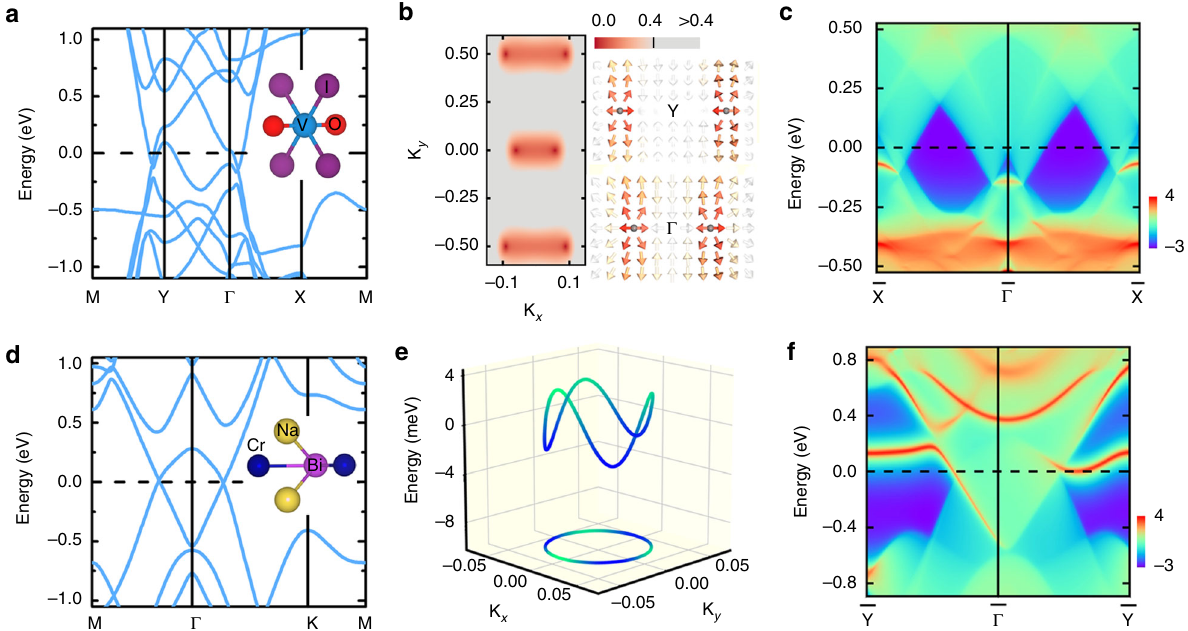
Fig. 5 Realization of mixed topological semimetals in two-dimensional ferromagnets. Including SOC, the electronic band structures of the stable single- layer compounds a VOI 2 and d Na 2 CrBi display band crossings with non-trivial topological properties in the mixed phase space of crystal momentum k = ( k x , k y ) and magnetization direction θ . Side views of the corresponding unit cells are shown as insets. b The signatures of the mixed Weyl points for in-plane magnetized VOI 2 manifest in the momentum-resolved direct band gap (color scale in eV) and in the distribution of the Berry curvature fi eld shown as arrows throughout the complex phase space, con fi rming the presence of four nodal points with the same topological charge. Ranging from white (small) to dark red (large), the arrow ’ s color illustrates the magnitude of the Berry curvature fi eld. c Electronic structure of a semi-in fi nite ribbon of VOI 2 , where the state ’ s localization at the edge is indicated by colors ranging from dark blue (weak) to dark red (strong). e In the mirror-symmetric plane, the band crossings in perpendicularly magnetized Na 2 CrBi form a mixed nodal line that disperses in energy. f The band structure of a semi-in fi nite Na 2 CrBi ribbon reveals characteristic edge states due to the non-trivial mixed